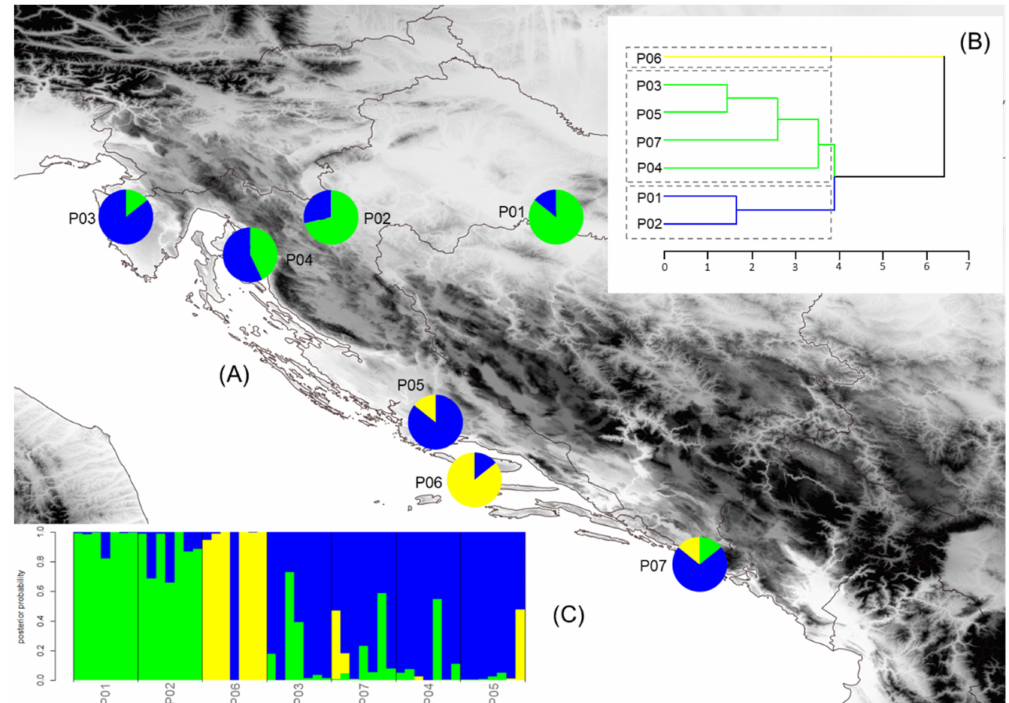
Figure 1. Results of the multivariate statistical methods for fruit and seed morphometric analysis and locations of the seven sampled Sorbus domestica populations. ( A ) Geographical distribution of three groups of populations detected from K-means clustering (the proportions of the ancestry of each population in each of the defined clusters are color-coded: cluster A– green, cluster B–yellow, cluster C–blue); ( B ) Hierarchical tree dendrogram; ( C ) Barplot with posterior probabilities of classification of each individual into each group from the results of the classification discriminant analysis. Acronyms of